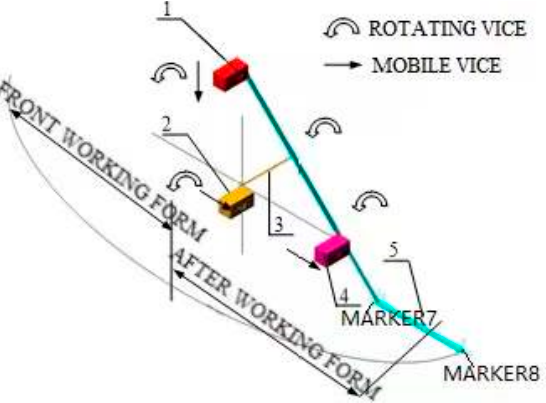
Figure 11. The model motion diagram. 1. Longitudinal slider; 2. Frame slider; 3. Crank; 4. Horizontal slider; 5. Rocker.